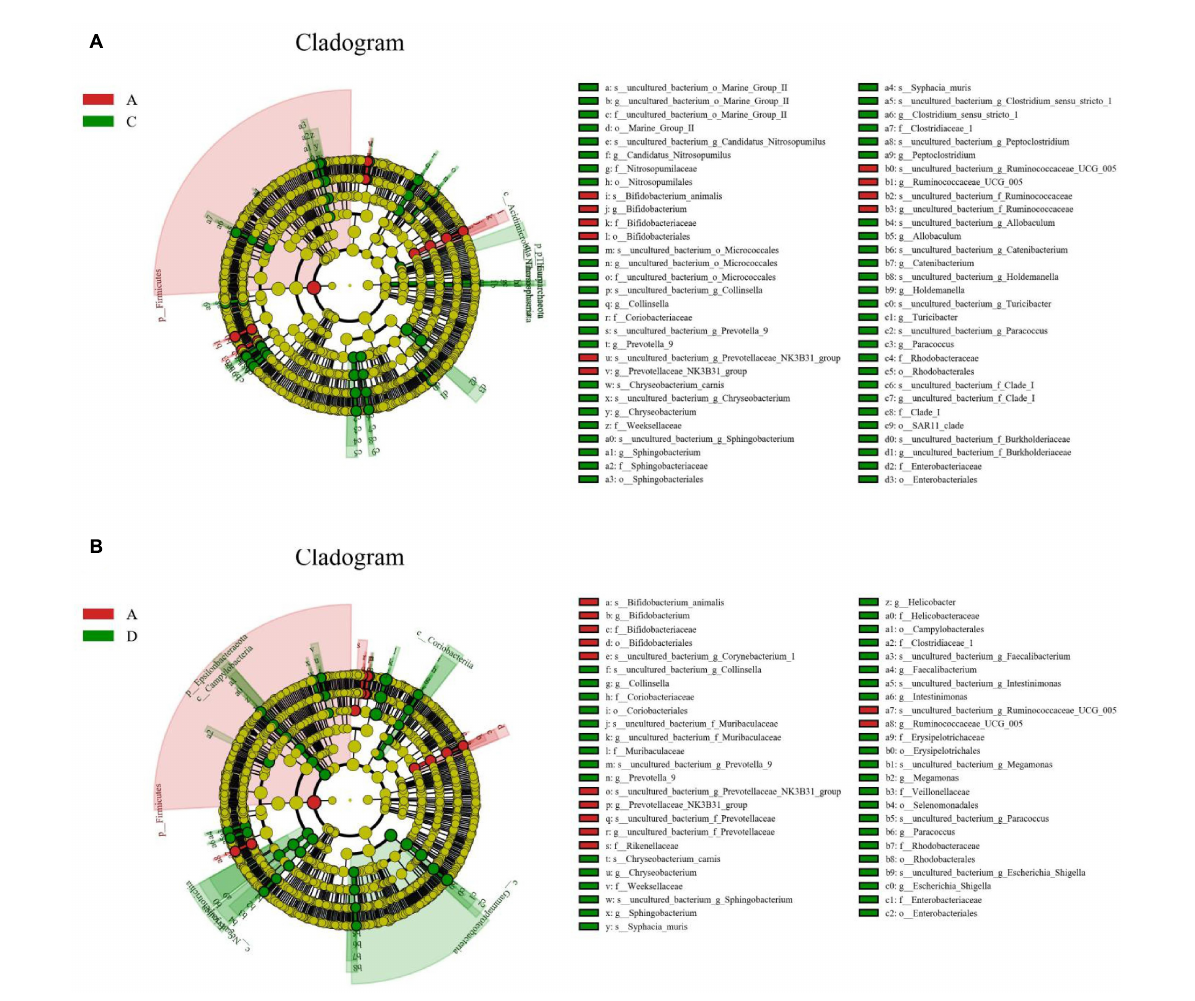
FIGURE5 Identification of differential taxa associated with black soldier fly oil administration in pigeon. Each circle in cladogram represents a bacterial taxon and red and green circles indicate differential taxa. (A,B) Cladogram indicated the phylogenetic distribution of gut